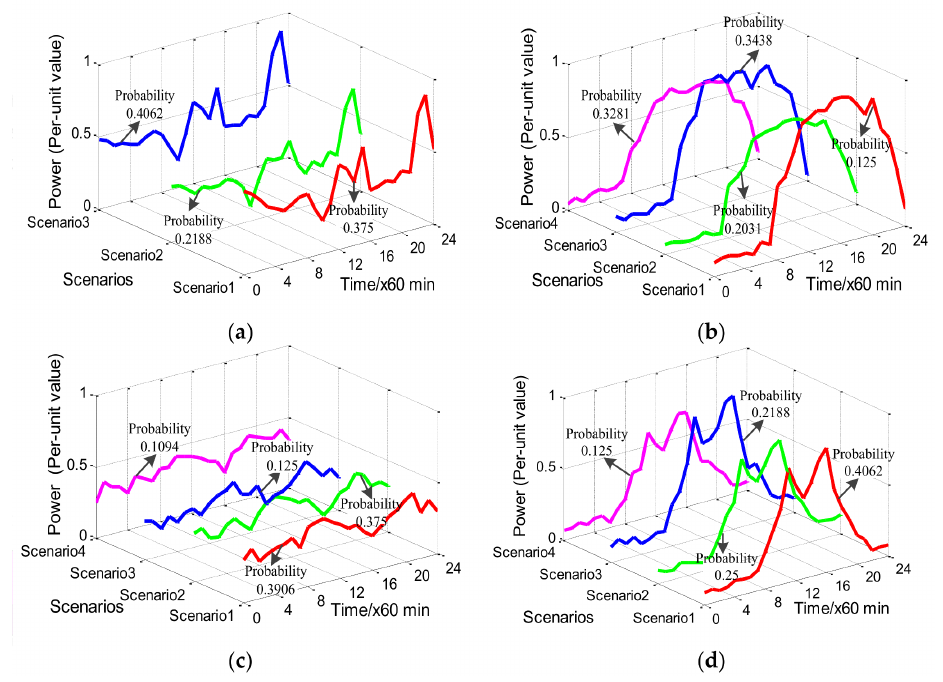
Figure 6. The timing scenarios of the summer cold load on weekdays for typical functional districts.